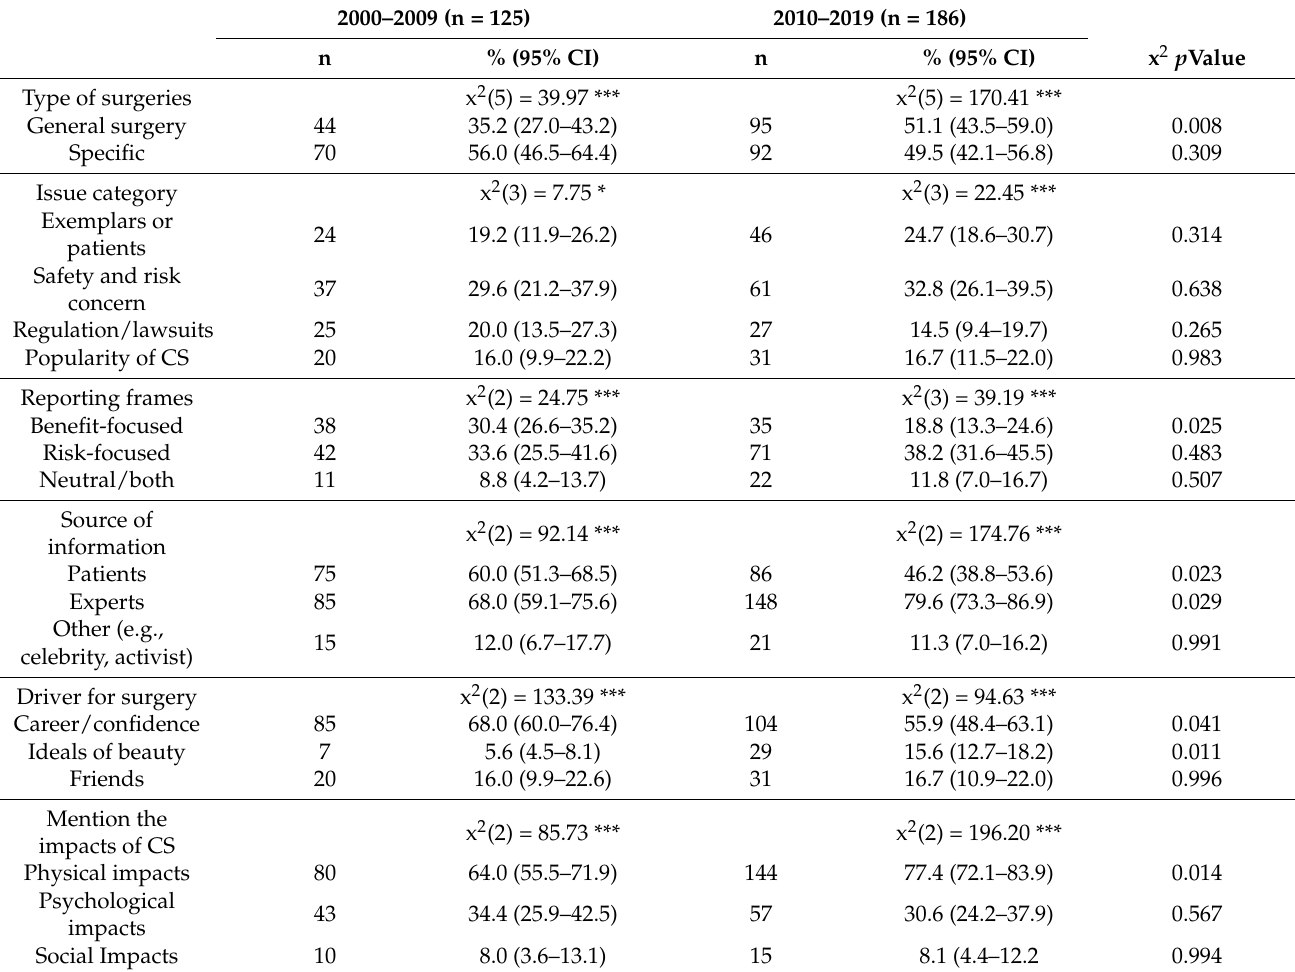
Table 3. Newspaper reporting on cosmetic surgery across